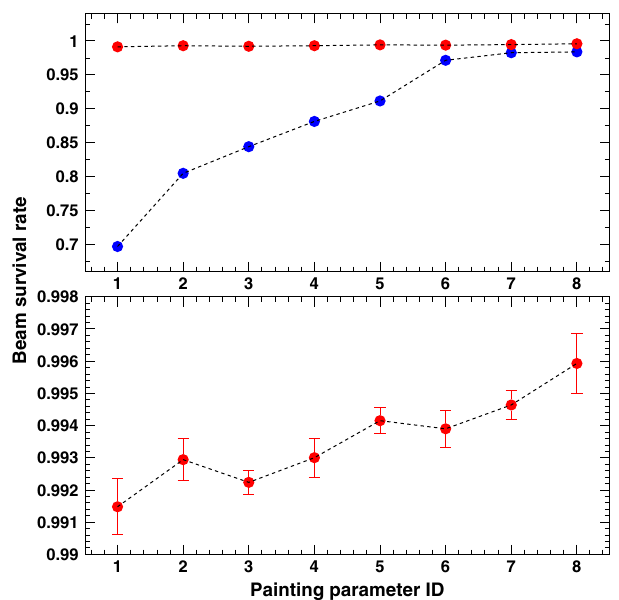
FIG. 21. (Upper) Beam survival rates measured with the systematic combinations of transverse and longitudinal painting of IDs 1 – 8 listed in Table II, where the blue circles are the previous values evaluated from the experimental data in Fig. 10, while the red circles correspond to the new ones taken with the upgraded injection energy of 400 MeV for a similar beam intensity of 553 kW. (Lower) Magnified plot of the red data in the upper